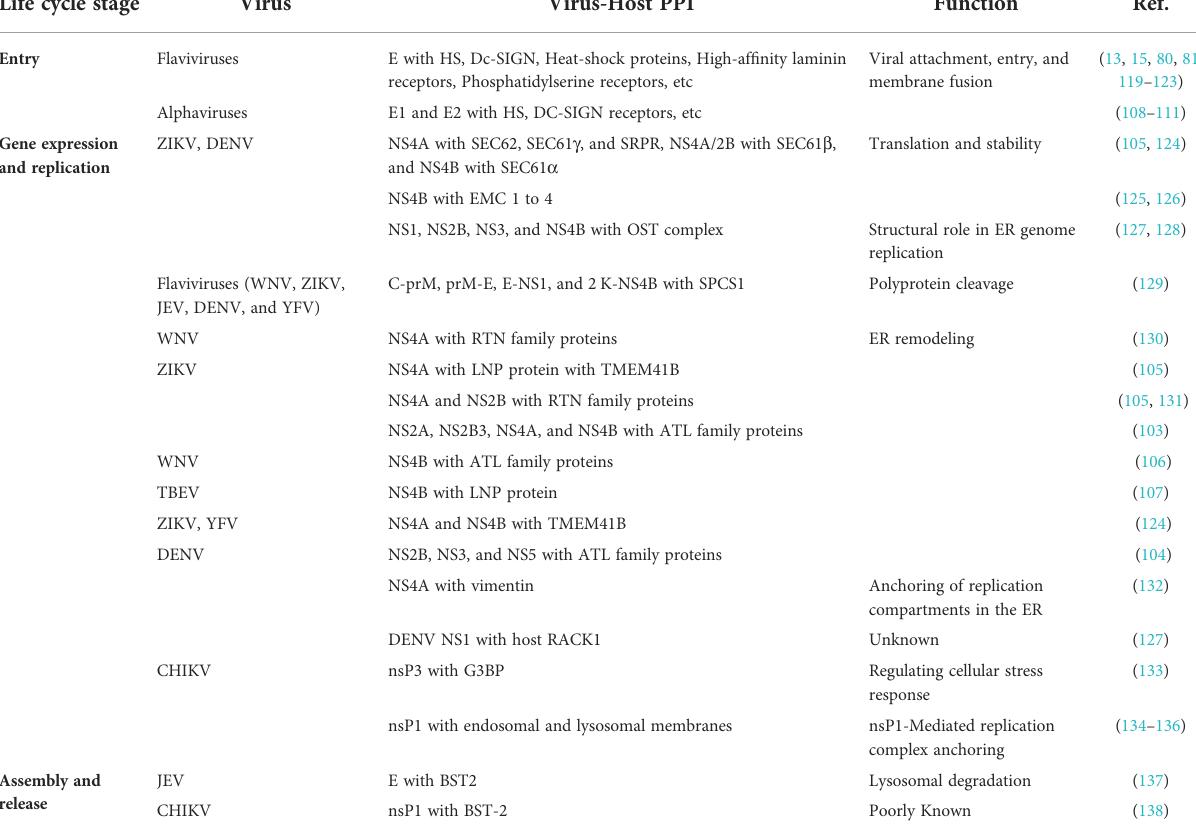
TABLE 4 Virus-Host PPIs found in the virus life